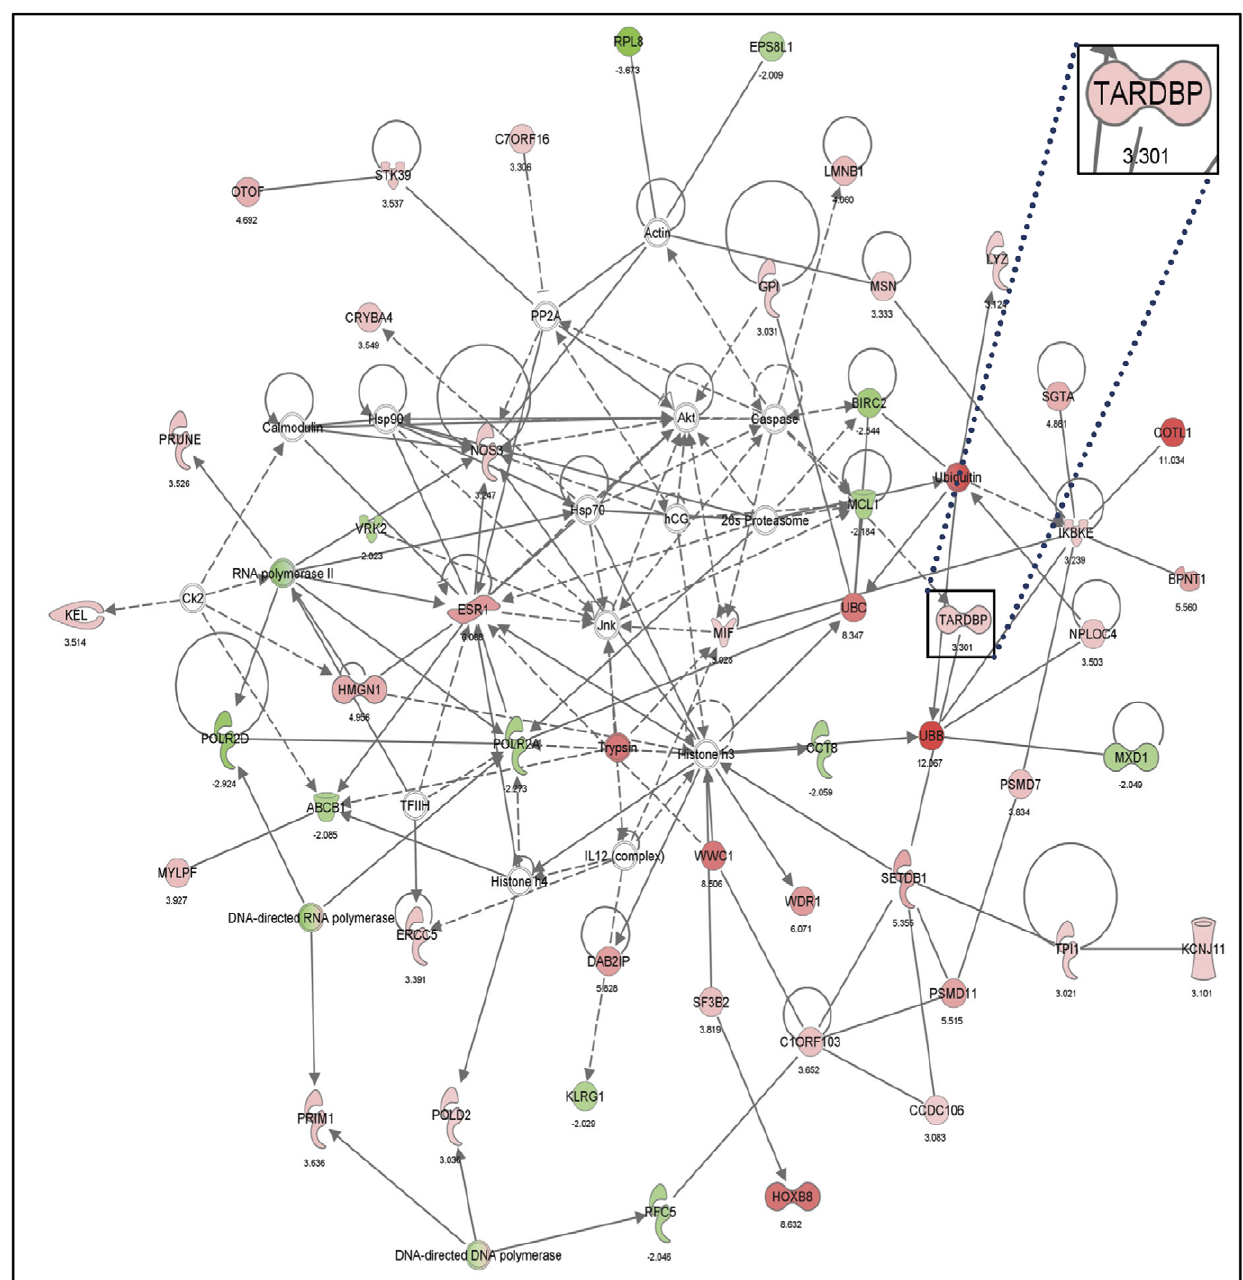
Figure 4. Protein interaction network map of hits from the RNAi screen. The data from the RNAi screen was processed to calculate MAD scores and was used for Ingenuity pathway analysis (IPA). The network annotated ‘‘Skeletal and Muscular System Development and Function, Tissue Morphology, Inflammatory Response’’ ranked at the top with the highest score and is shown in the figure. The hits that increased SOD1 levels above 3SD are shown in red and the ones that decreased the signal below 2 2SD are shown in green. The proteins represented by color-less nodes were below the selection criteria. Direct interactions are shown in bold lines and indirect interactions are shown in broken lines. (See Table S1 for proteins in this network)